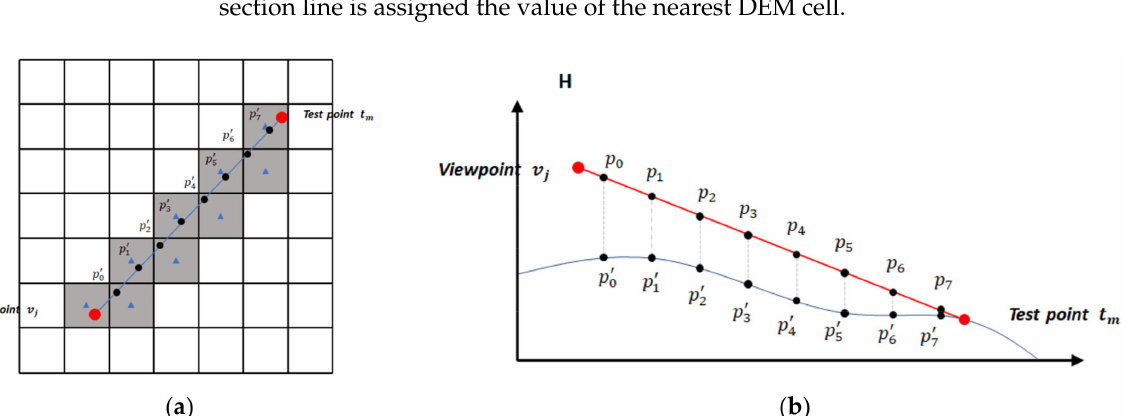
Figure 3. Diagram of 3D Bresenham algorithm and line-of-sight algorithm. ( a ) describes 3D Bresenham algorithm. The blue line segment is the projection of the line segment formed by two points on the terrain. The gray grids are the grids through which the line segments pass. The black points are the intersections of the vertical lines from the center of the gray grids to the blue line segment. A black point’s elevation value is represented by the elevation value of the nearest DEM cell. ( b ) shows line-of-sight algorithms we use. The blue line represents the terrain section